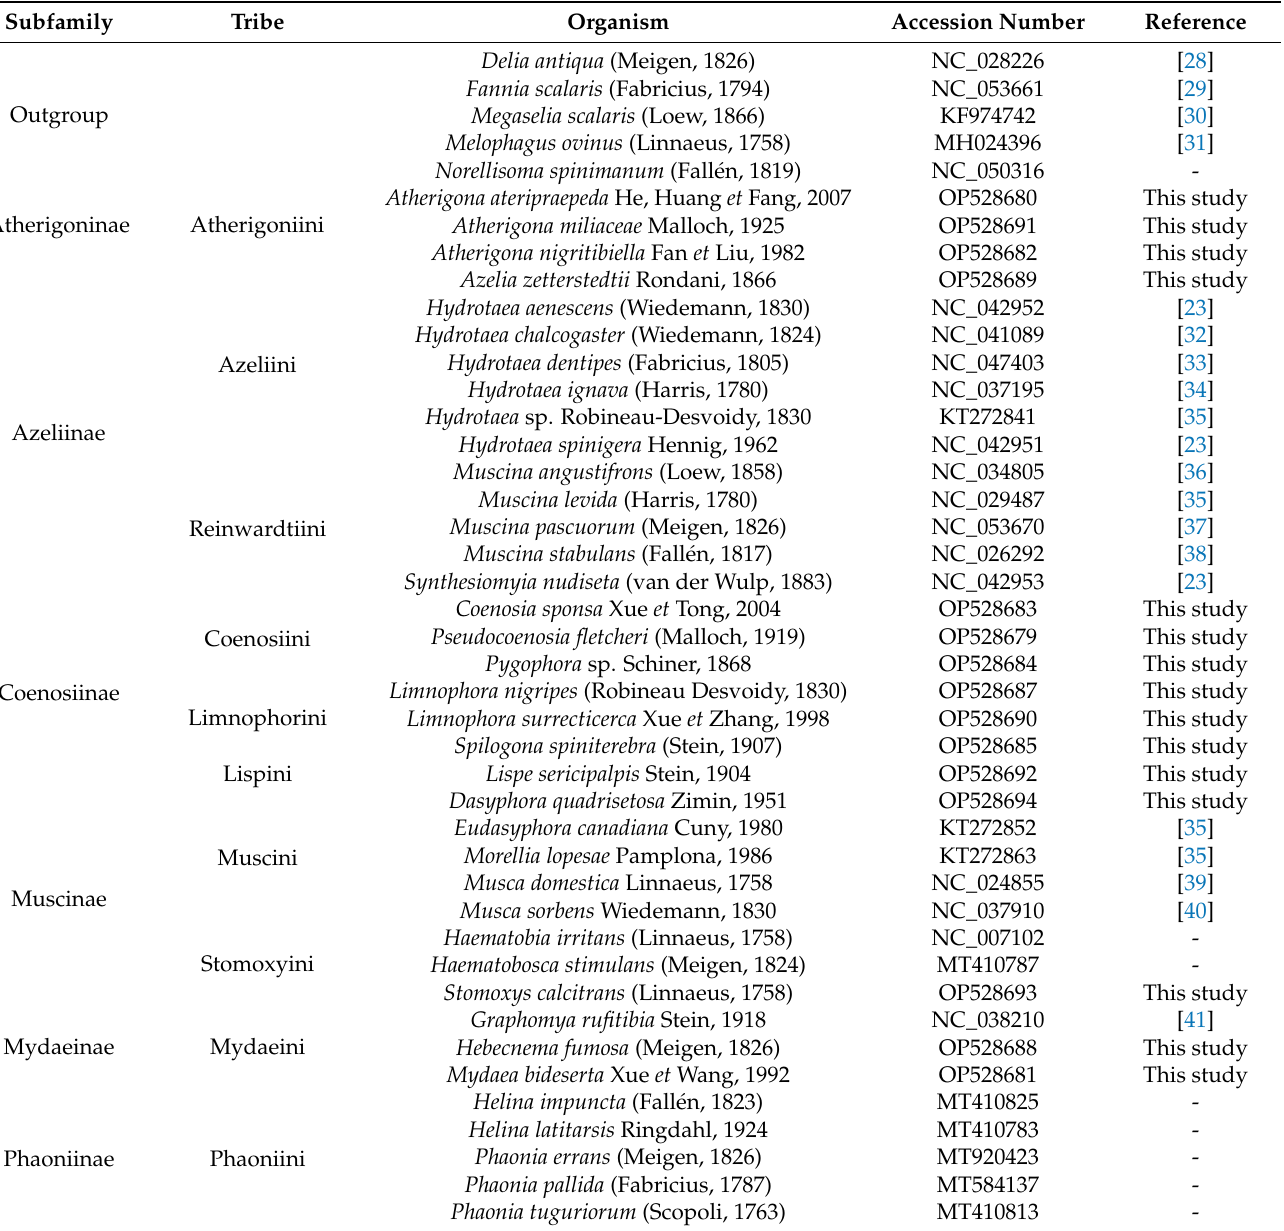
Table 1. Information of sampled sequences and their systematic ranks were used in this study. The “-” means that we cannot find its reference in both NCBI website and